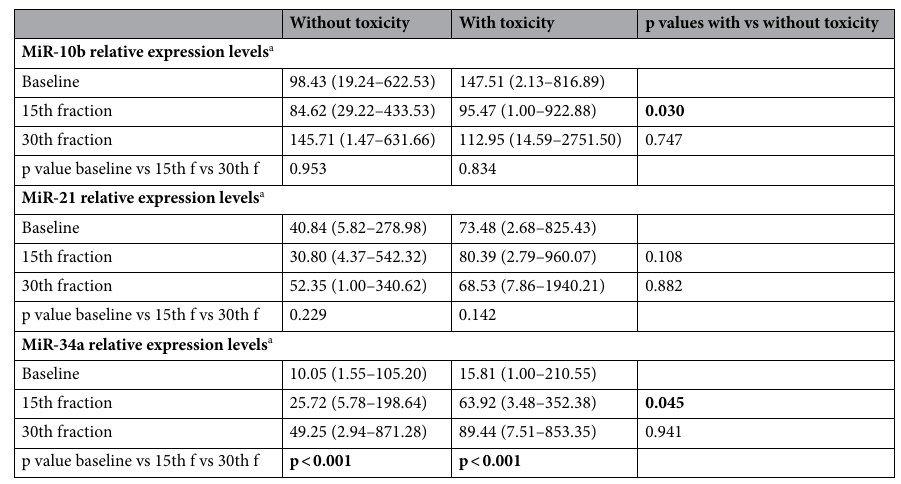
Table 3. Differences in miR-10b/21/34a relative expression levels between the patients without and with toxicity within GB patients, at Baseline, the 15th, and the 30th fraction of radiation therapy. a Median values of relative miR-10b/21/34a expression with minimum and maximum in parentheses. p values equal or less than 0.05 were considered significant according to the result of Wilcoxon’s signed rank test (between 2 groups) and Friedman’s test for 3 groups comparisons (in bold style). p values between 0.1 and 0.05 were considered as statistical trend, presented in bold style.